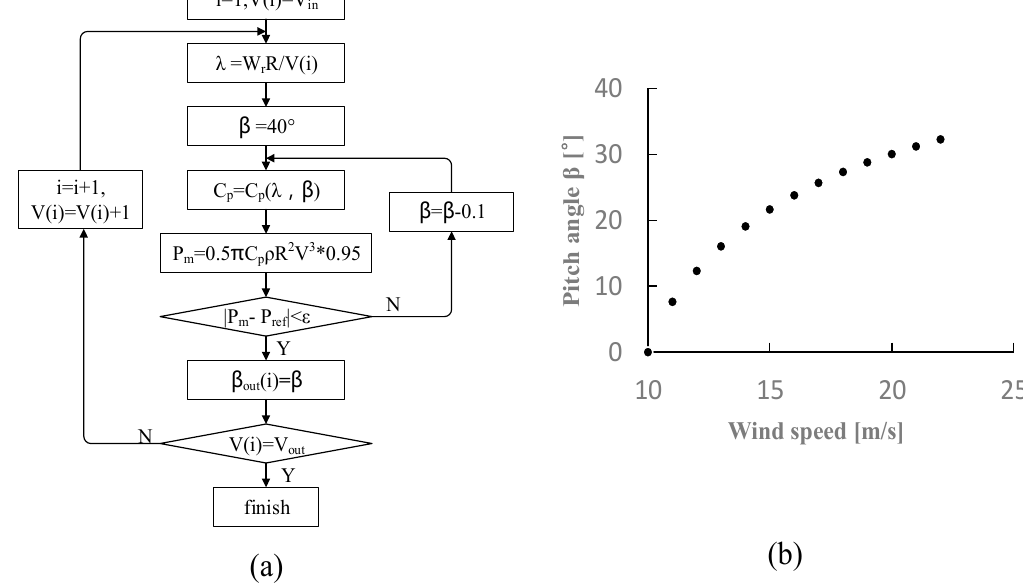
Figure 3. ( a ) Flow chart for the calculation of pitch angle; ( b ) calculated results.